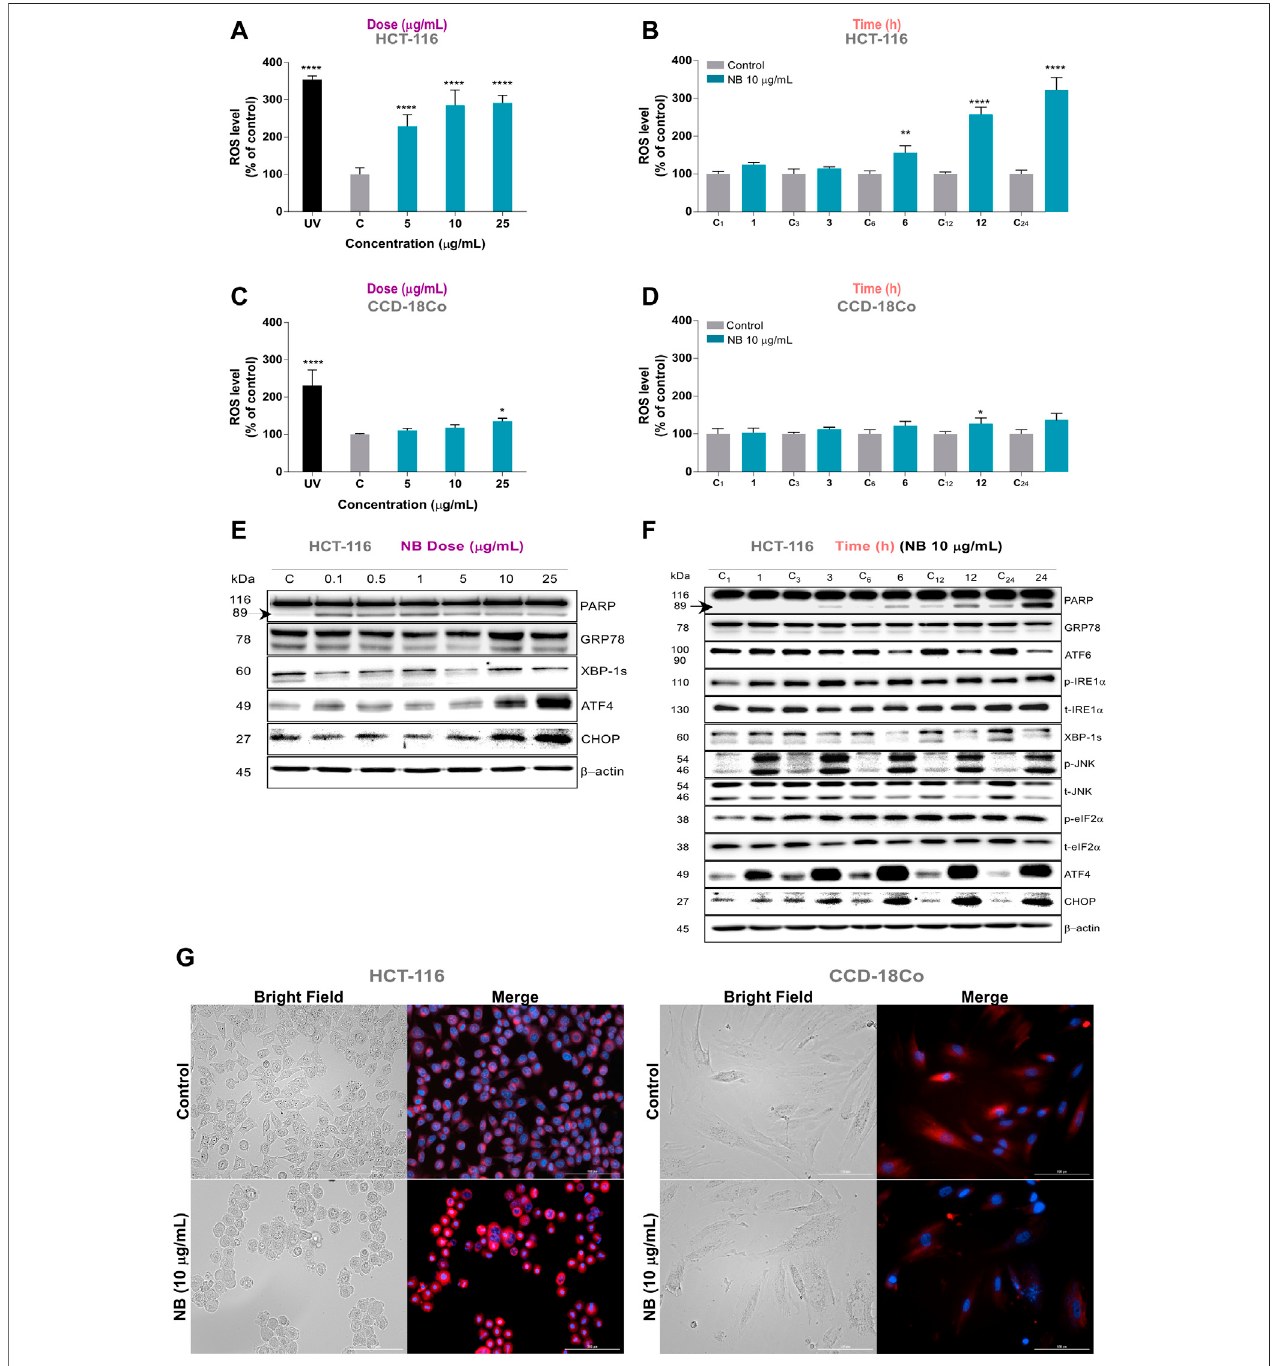
FIGURE2| Effectof Dolabellaauricularia extract(NB)onROSgenerationandconcomitantERstressincoloncells.IntracellularROSlevelsweremeasuredinHCT- 116 and CCD-18Co using the 2 ′ ,7 ′ -dichlorodihydro fl uorescein diacetate (H 2 DCF-DA) fl uorescence probe after NB treatment in a dose- (A , C) and time-dependent manner (B , D) . Time in hours is indicated on the X axis and is preceded by “ C ” for control samples. Data were compared to the control (untreated cells plus less than 0.2 % DMSO) and are presented as the mean ± SD of three independent experiment. p -values were calculated by comparison with untreated cell lines using ANOVA. * p -value < 0.05, ** p -value < 0.01, *** p -value < 0.001, and **** p -value < 0.0001. The ability of NB extract to modulate ER stress-related proteins in HCT-116 cells wasanalyzed bywesternblotanalysis.Effect ofdifferentconcentrationofNBafter 24 hincubation isshown in E and effectof10 µg/mL ofNB intime isshown in F . Time(h)isindicatedontheupperpart andispreceded by “ C ” forcontrolsamples. β -Actin wasusedasaloadingcontrol.Densitometryanalyses of E and F areshown in SupplementaryFigures1and2 ,respectively.RepresentativeimagesofHCT-116(left)andCCD-18Co(right)cellstreatedwith10 µg/mLNBextractinbright fi eldand merged fl uorescence channels corresponding to DAPI (Hoechst, nucleus) and Texas red (ER Tracker Red, endoplasmic reticulum) at 20 × ( G ).